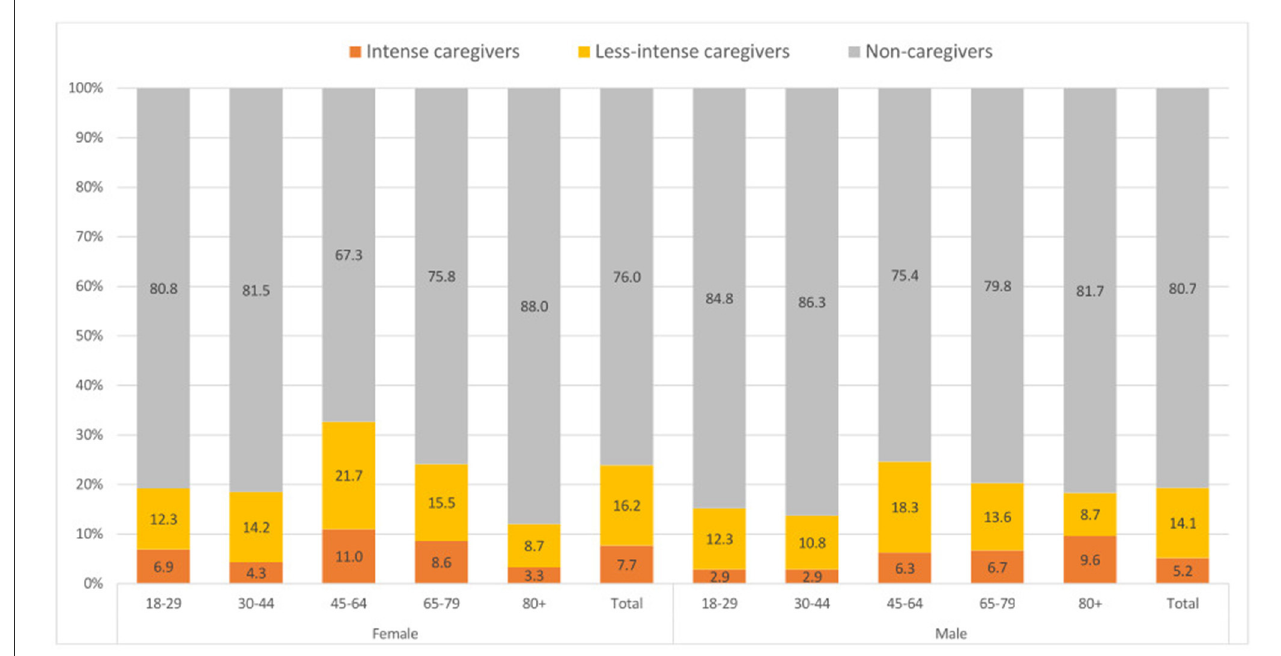
FIGURE1 Percentage of informal care-giving activities by gender and age group in years (weighted analyses). Percentages may not total 100 due to rounding.